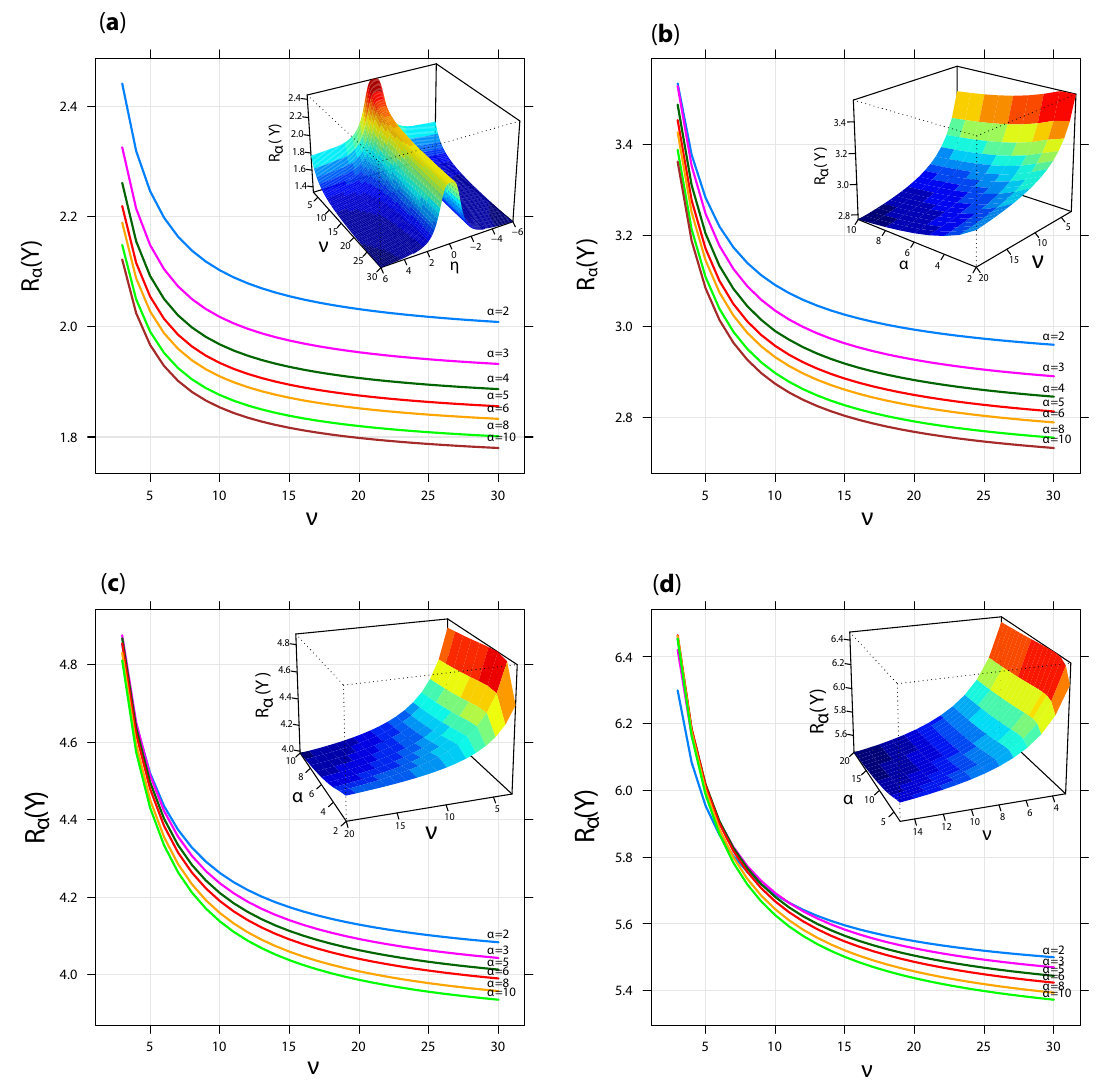
Figure 1. Skew- t Rényi entropy [ R α ( Y ) ] versus degree of freedom parameter ( ν = 3, . . . ,30) for cases ( a – d ) described above. Each line corresponds to order α = 2,3,4,5,6,8,10. 3d-subplot of case ( a ) corresponds to R α ( Y ) versus ν and η , whereas the 3d-subplots of cases ( b – d ) are R α ( Y ) versus ν and α